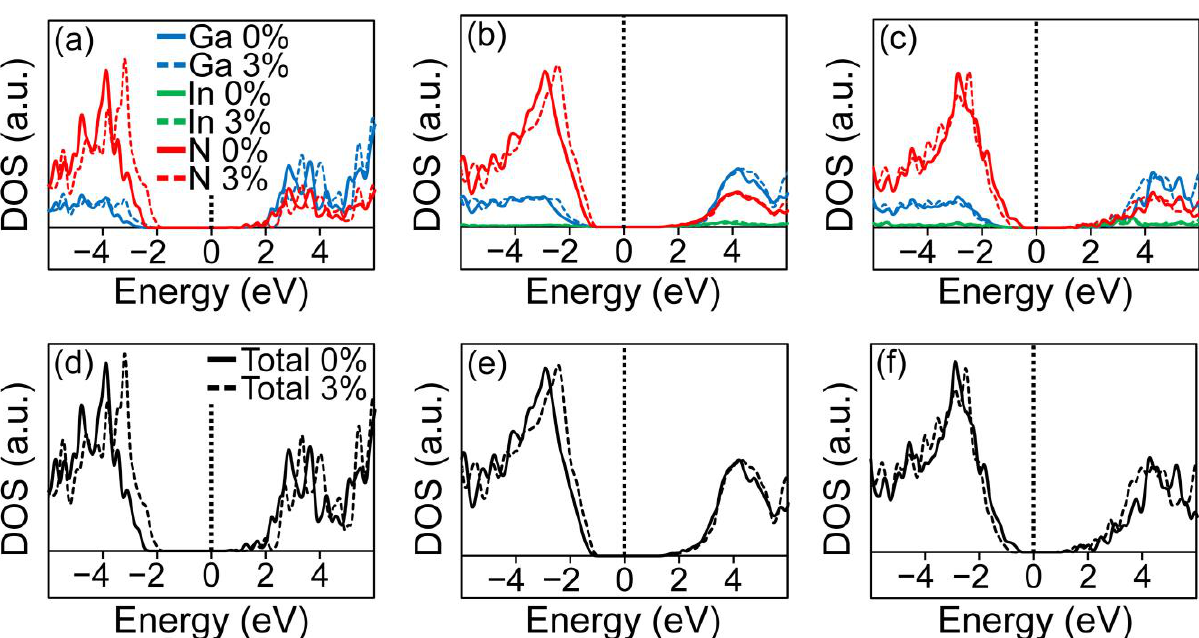
Figure 3. Partial DOS diagrams for each element ( top , colored diagrams) and total ones ( bottom diagrams) obtained from relaxed and 3% strained short-period superlattices. ( a , d ) Binary GaN; ( b , e ) superlattices with In 0.5 Ga 0.5 N quantum wells; and ( c , f ) superlattices with InN quantum wells.